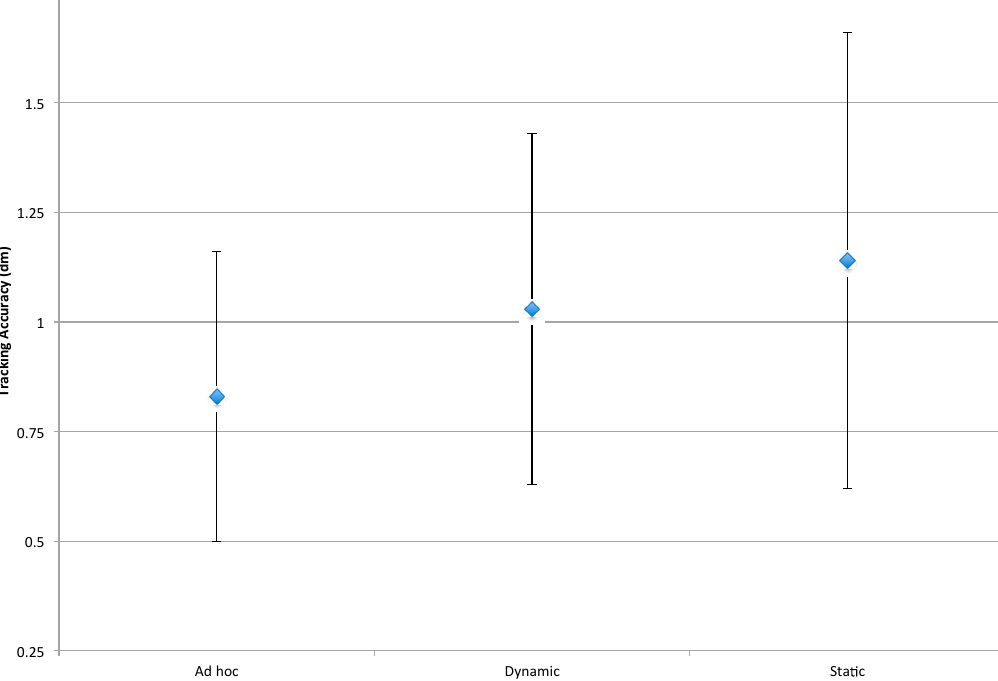
Figure 12. Interval plot for tracking accuracy. n = 160, ANOVA, 1 df , p < 0.05.